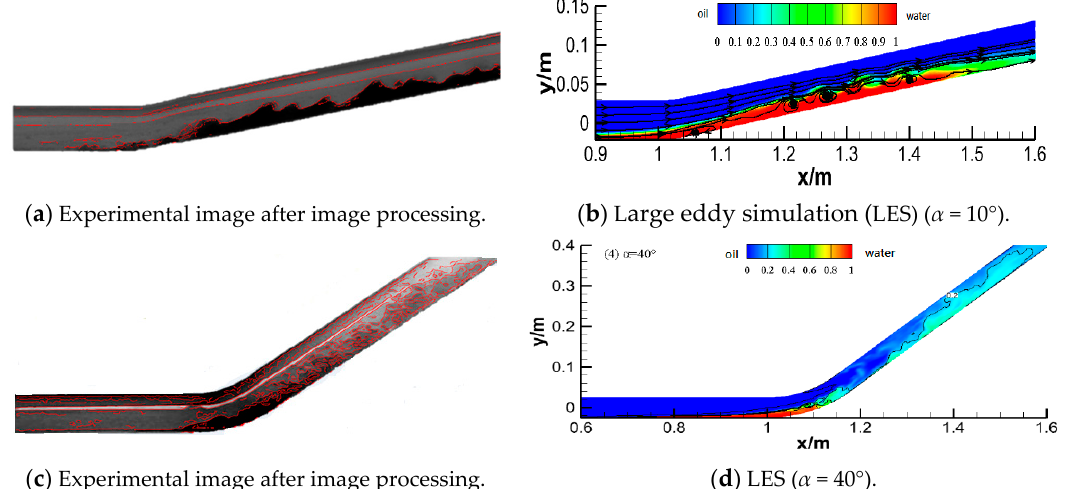
Figure 7. Comparison of two methods ( t = 3 s) [29].